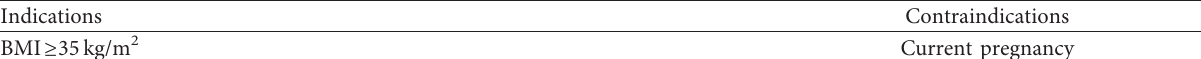
Table 1: Summary of indications and contraindications for bariatric surgery according to the SMOB (Swiss Society for the Study of Morbid Obesity and Metabolic Disorders)